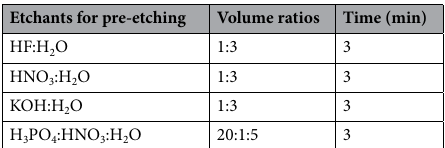
Etchants for pre-etching